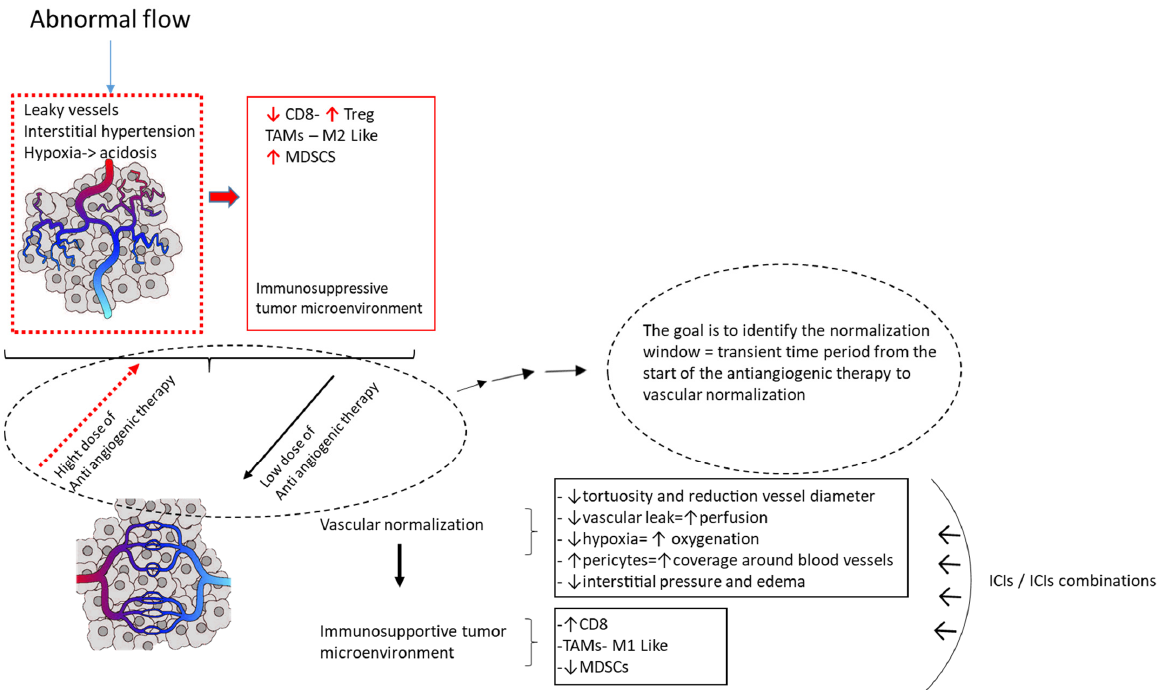
Figure 2. Liver tumor display vascular abnormalities. Liver tumor vessels have abnormal blood flow and are excessively leaky. This results in hypoxia and acidosis which contribute to immunosuppression in the TME: expansion of immunosuppressive regulatory T (Treg) cells and of myeloid-derived suppressor cells (MDSC); decrease in the infiltration of the CD8+ T cells; reprogramming of tumor-associated macrophages (TAMs) from an anticancer M1-like phenotype towards the pro-tumor M2 phenotype. The normalization process is transient and its onset provides an immune-supportive microenvironment, an efficient infiltration of immune cells and the delivery of anticancer therapy including immunotherapy. A judicious application of antiangiogenic therapy, neither too high nor too low, allows for the normalization window and the related benefits to be obtained.